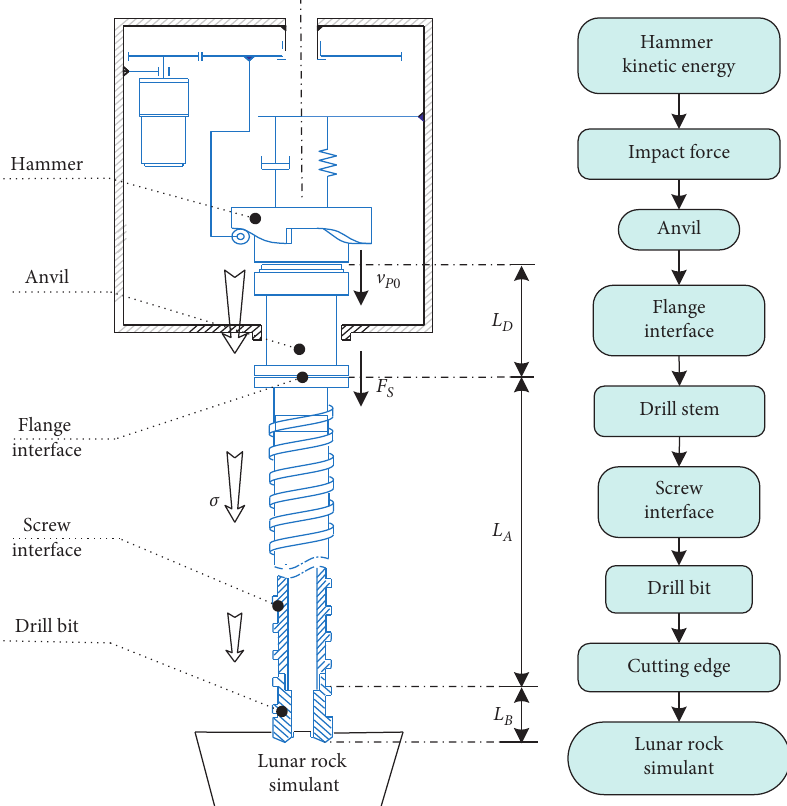
Figure 1: The transmission diagram of impact stress in the lunar rock drilling process.